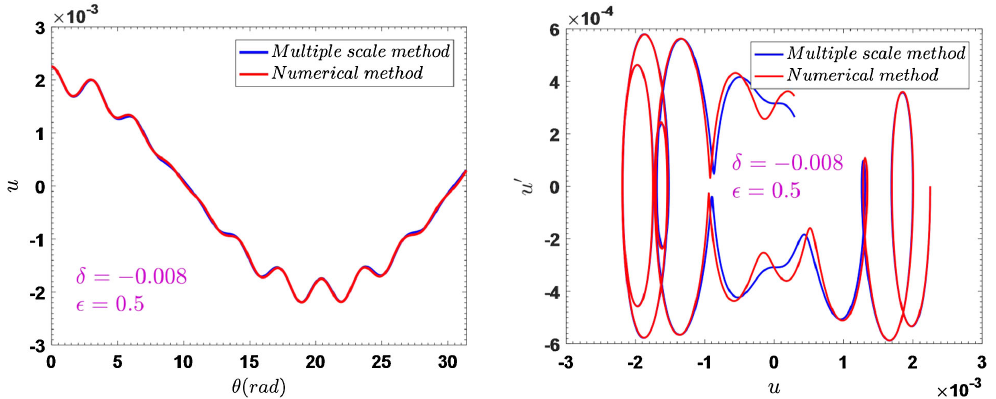
FIG. 2. Trajectories (left) and phase motions (right) for parameter pairs ð δ ; ε Þ ¼ ð − 0 . 008 ; 0 . 5 Þ in the stable region. The MMS is in blue, and the direct numerical integration is in